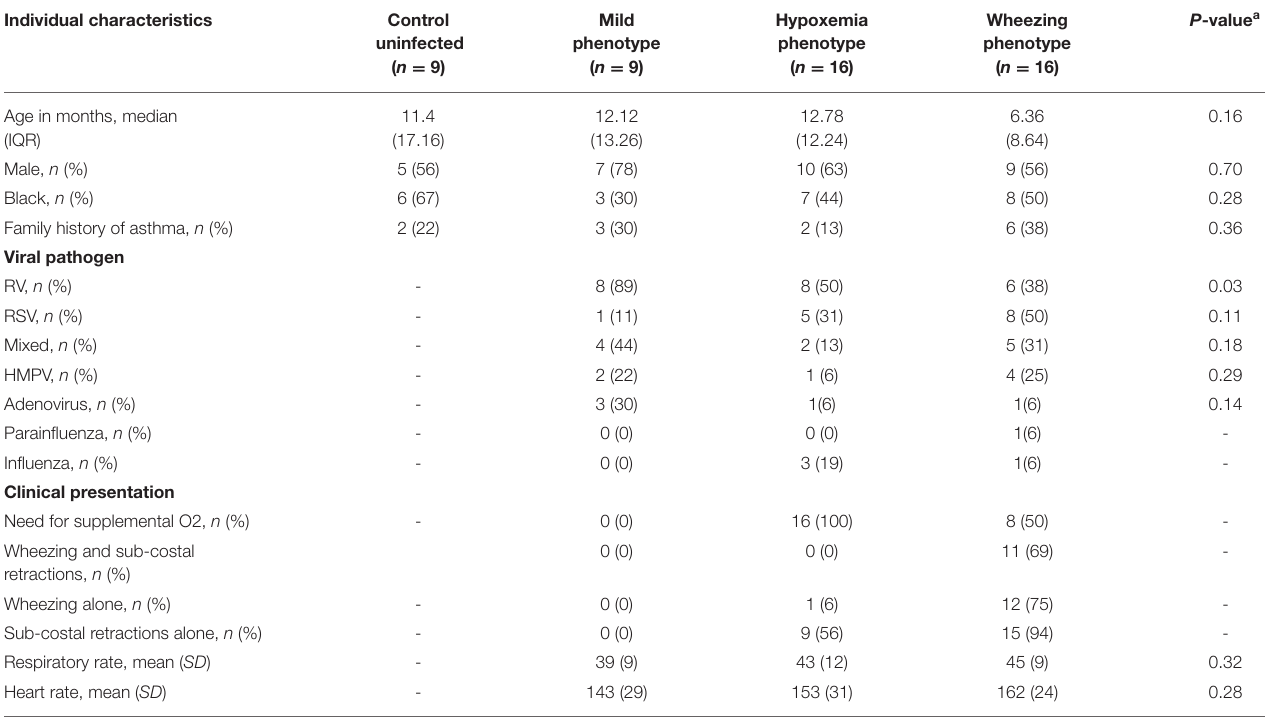
TABLE 1 | Baseline characteristics of all study subjects and clinical features of each viral respiratory infection phenotype. Individual